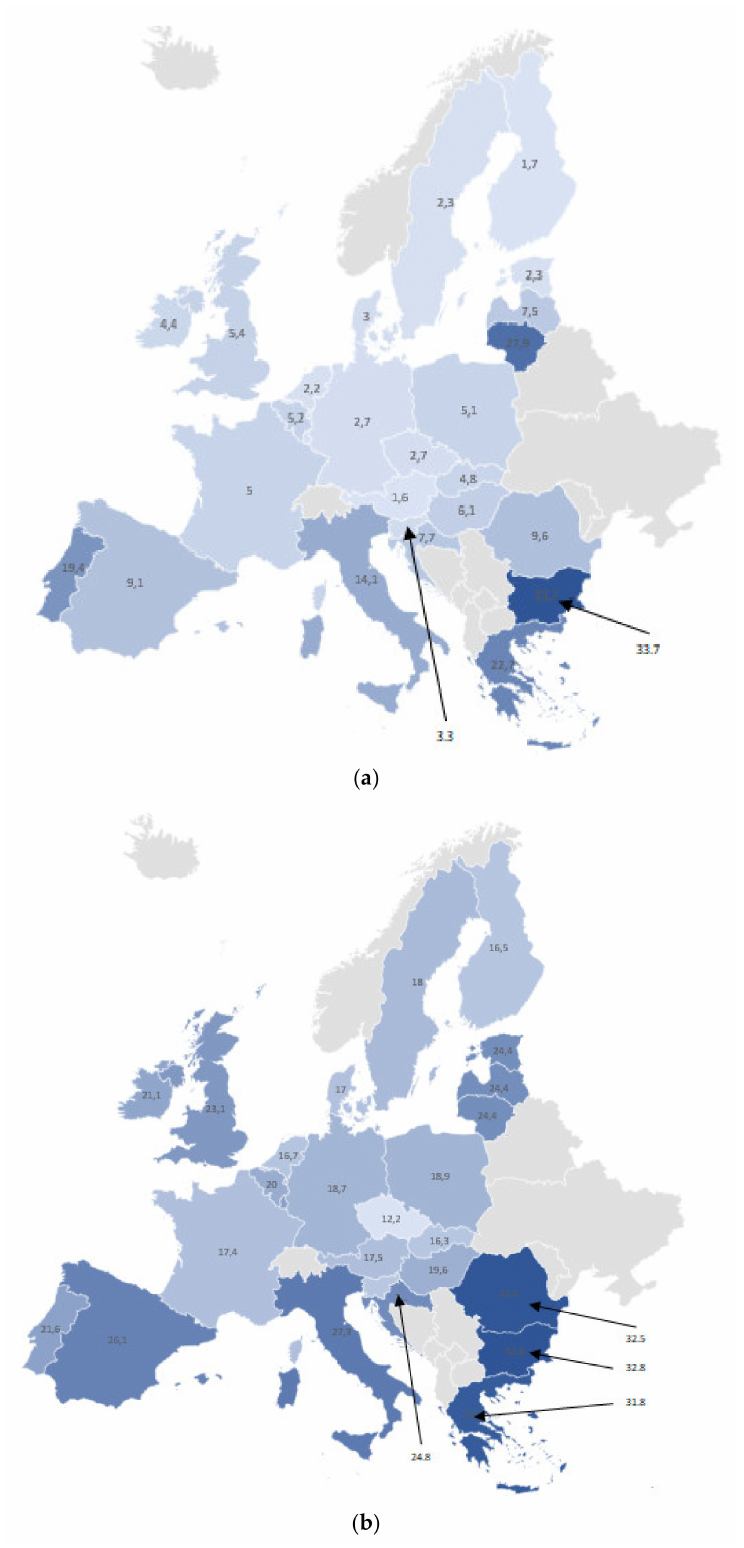
Figure 1. ( a ) 2018 Energy poverty indicator distribution (%); ( b ) 2018 Income poverty indicator distribution